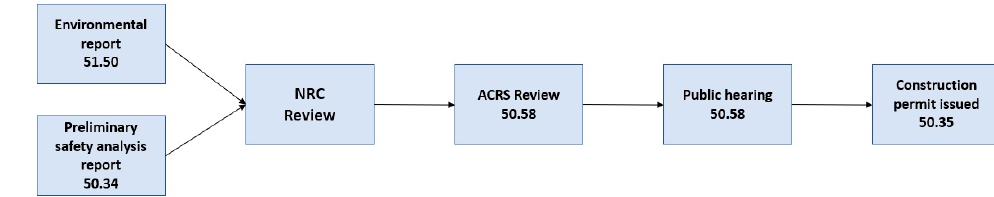
Figure 3. CP process of 10 CFR Part 50.